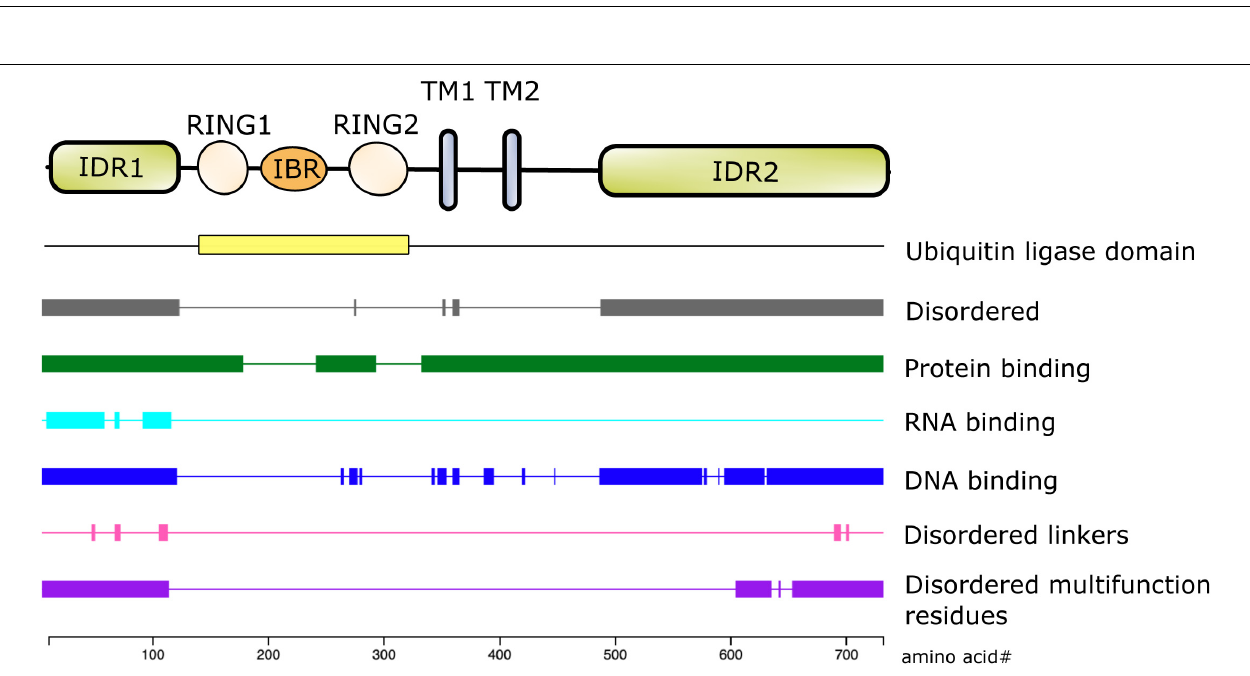
FIGURE 2 | Structure/function of NKLAM protein. The RING1-IBR-RING2 (RBR) domain has the ubiquitin ligase activity. RING2 contains the highly conserved, active site catalytic cysteine (C302), which is the defining feature of this family of RBR ligases. In addition to the two transmembrane (TM) domains, the N- and C-terminal ends of NKLAM are intrinsically disordered regions (IDR). Bioinformatic analysis using the DEPICTER server indicate the possible roles of the IDR in protein, DNA, and RNA binding.